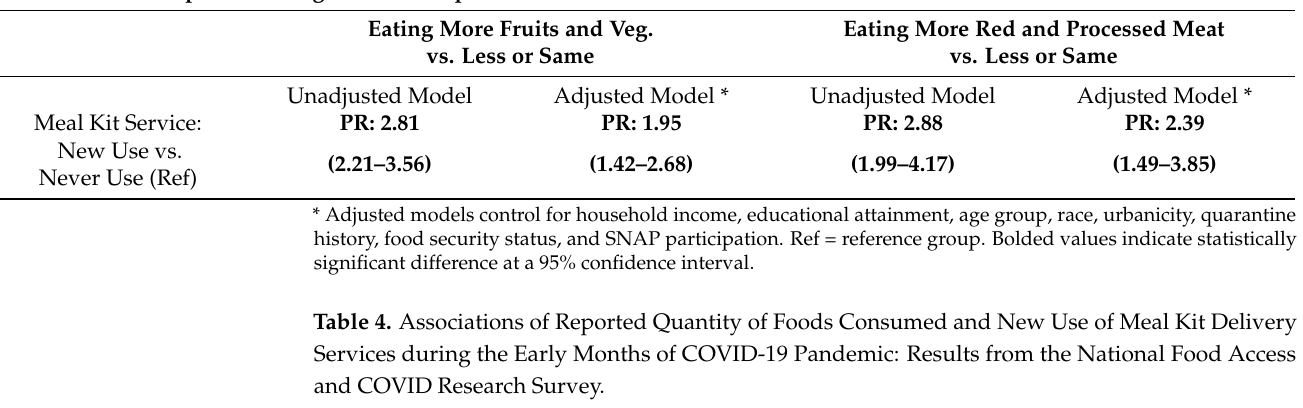
Table 3. Associations of Reported Changes in Dietary Behaviors and New Use of Meal Kit Delivery Services during the Early Months of COVID-19 Pandemic: Results from the National Food Access and COVID Research Survey.